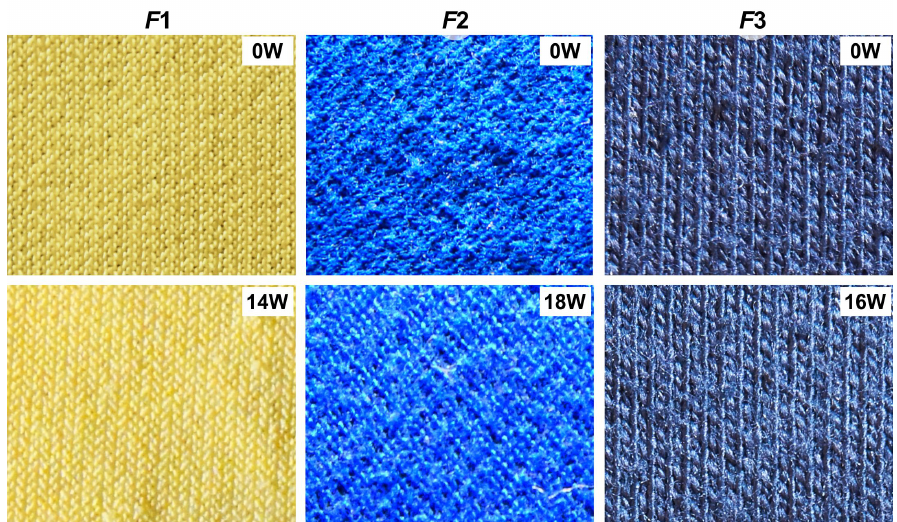
Figure 6. Knitwear surfaces after the standardized Martindale pilling test: 0W indicate fabrics without laser treatment; 14–18 W indicate fabrics after laser ablation.